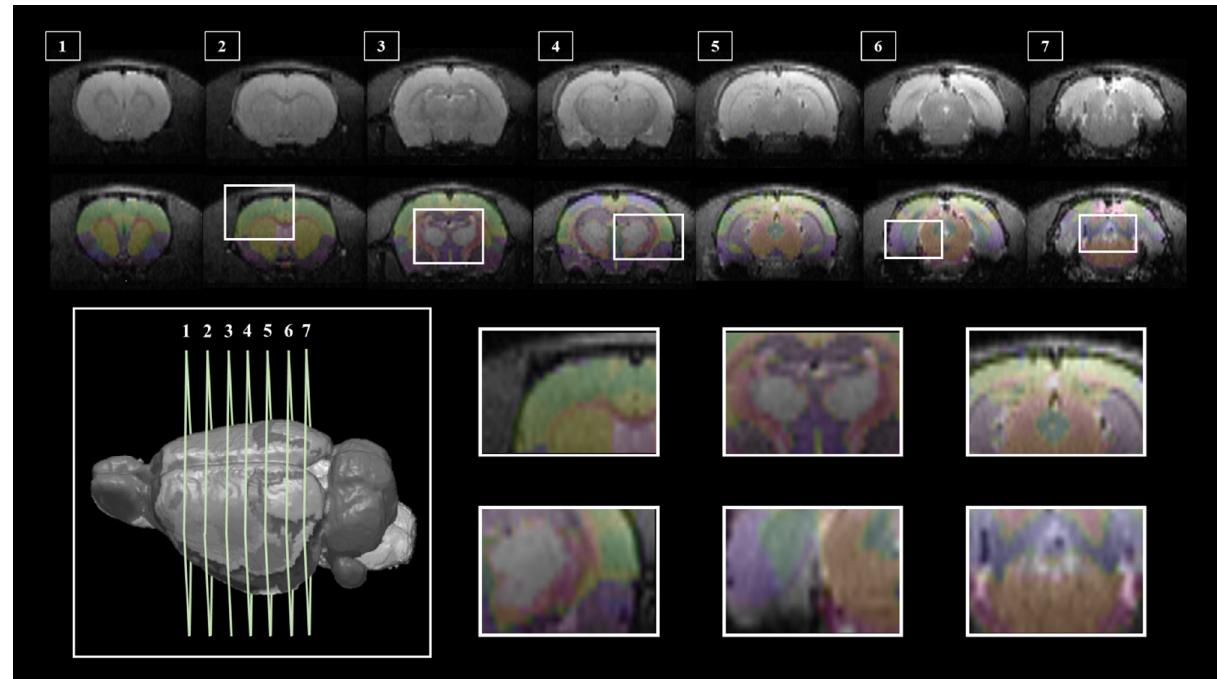
Figure 2. SIGMA Atlas-based Whole Brain Segmentation and Enrollment Results. Slices ( 1 – 7 ) shows the location of the segmentation result overlaid on the image data, 3D rendered RAT brain ( bottom left ) to show each slice location, and six detailed views show atlas overlays ( bottom right ).